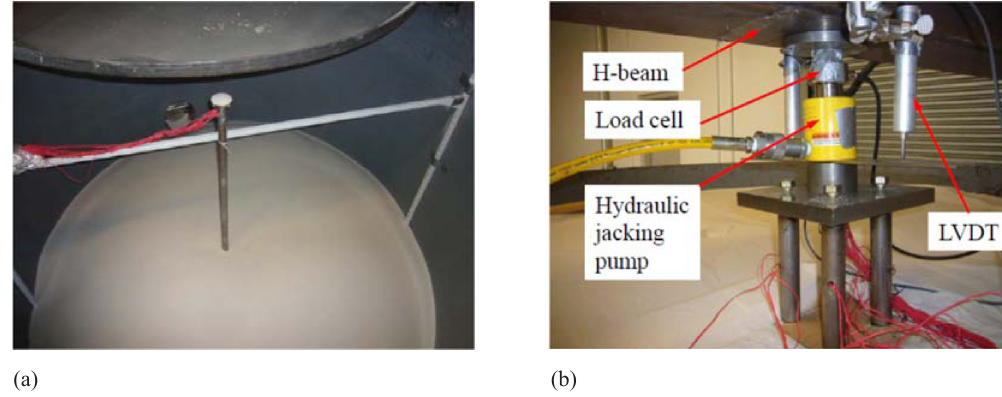
Fig. 3. Pile group test – preparation: (a) Pile installation; (b) 4-pile group